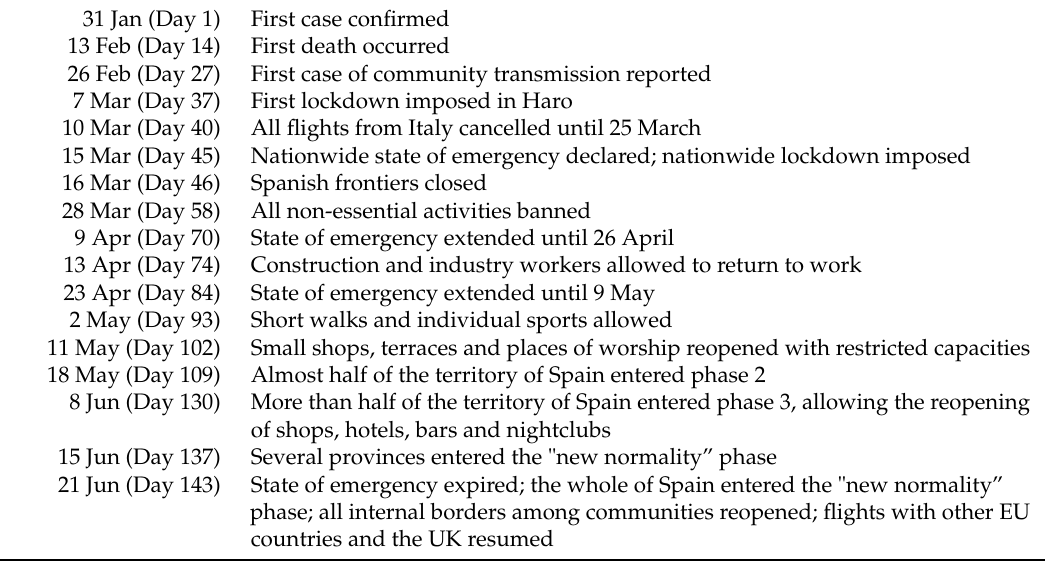
Table 4. Timeline of the COVID-19 pandemic in Spain (January 2020–June